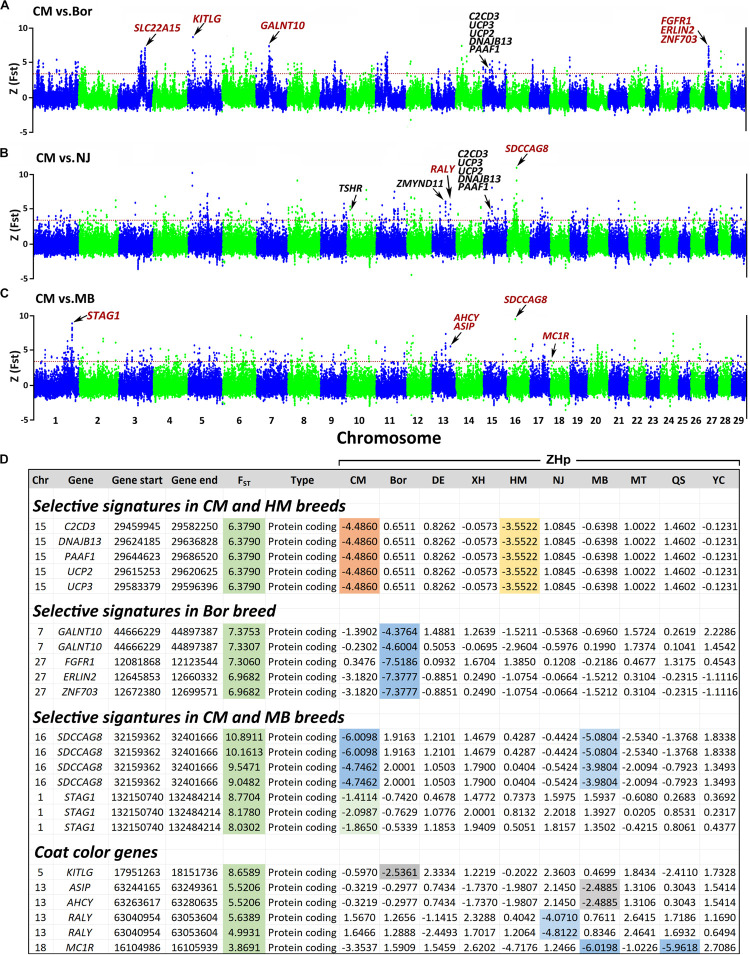
Genome-wide distributions of selection signatures in the CM vs Bor (A), CM vs NJ (B), and CM vs MB (C). ZHp scores of selection genes across the breeds (D). The ZFST and ZHp calculated for each sliding 100-kb window with steps of 50 kb across all autosomes. The red horizontal dashed line indicates the ZFST threshold value of 3.27. CM, Chongming white goat; Bor, commercial Boer goats; NJ, Nanjiang yellow goats; MB, Macheng black goats.